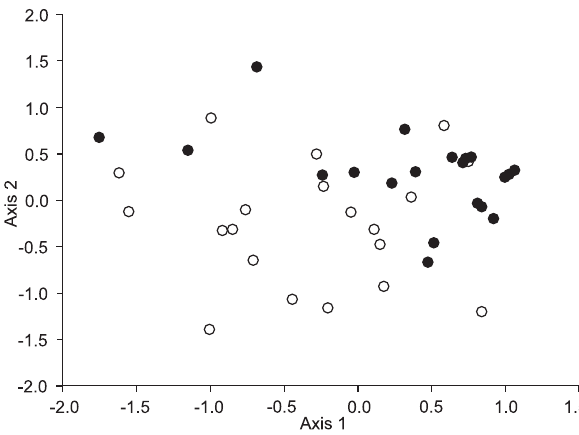
Figure 5. Ordination of sampling plots along the axes of Non- metric Multidimensional Scaling (NMDS) of anuran species com- position and abundances in two large rivers in the municipality of Cachoeiras de Macacu, state of Rio de Janeiro, Brazil. Black circles are plots with greater riparian forest cover, and white circles rep- resent plots with lesser riparian forest